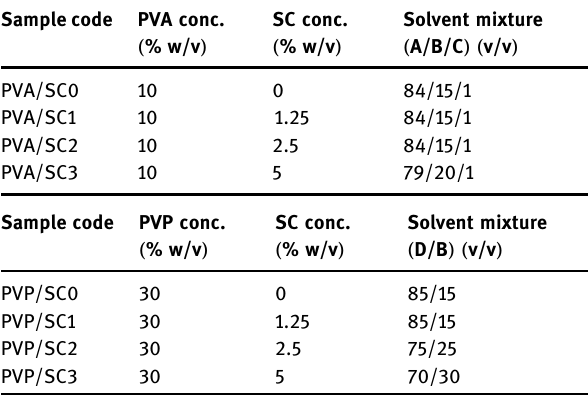
Table 1: Formulations of drug - loaded polymeric solutions Sample code PVA conc. ( % w/v